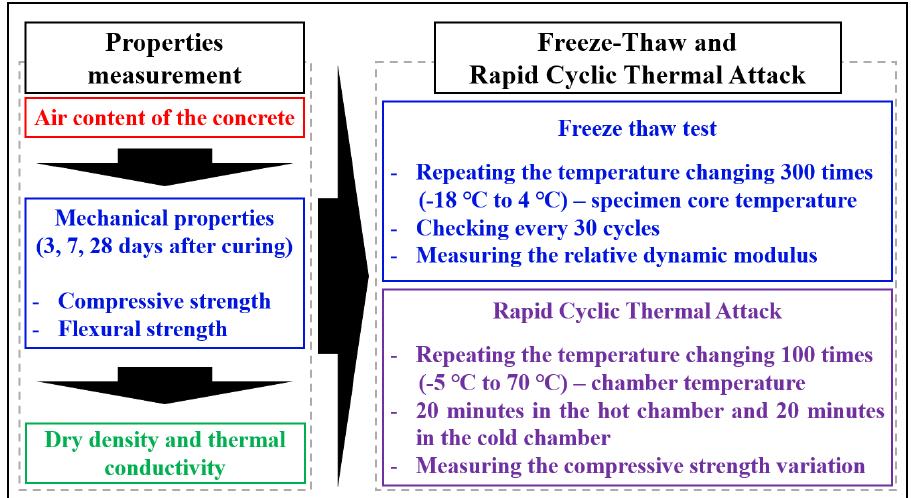
Figure 4. The details of the research flow.